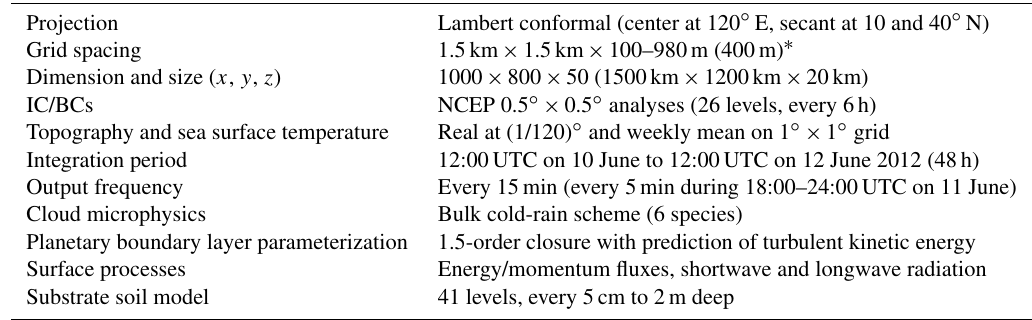
Table 1. The CReSS model domain configuration and physics used in this study.